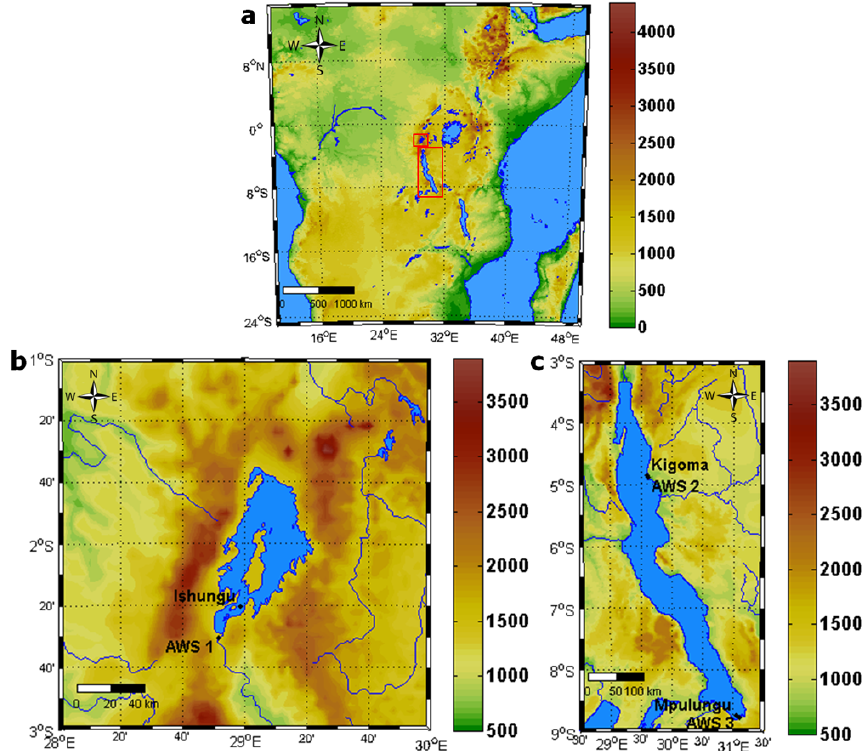
Fig. 1. (a) overview of East Africa with rectangles around Lake Kivu (upper) and Lake Tanganyika (lower), (b) Lake Kivu, (c) Lake Tanganyika. Surface altitude is shown in